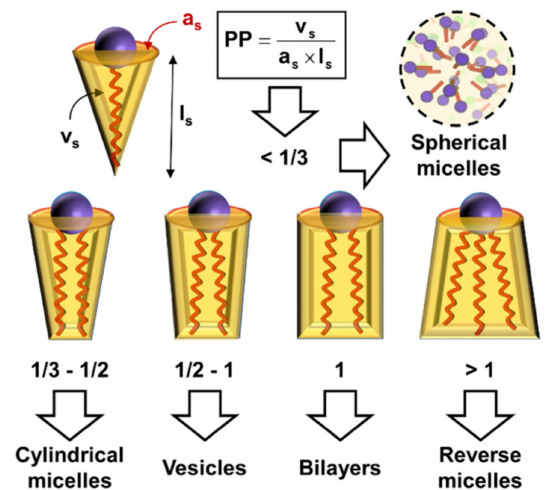
Figure 19. Relationships between the PP, the shape of the surfactant, and the self-assembled structure in aqueous media when PP <1 or in organic solvents for PP